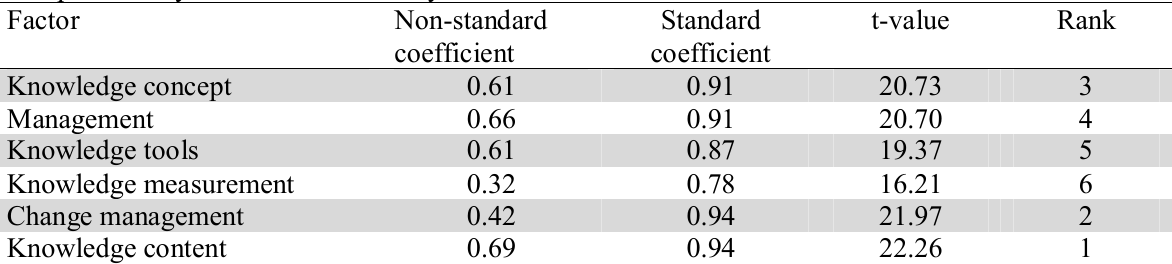
The preliminary results of factor analysis